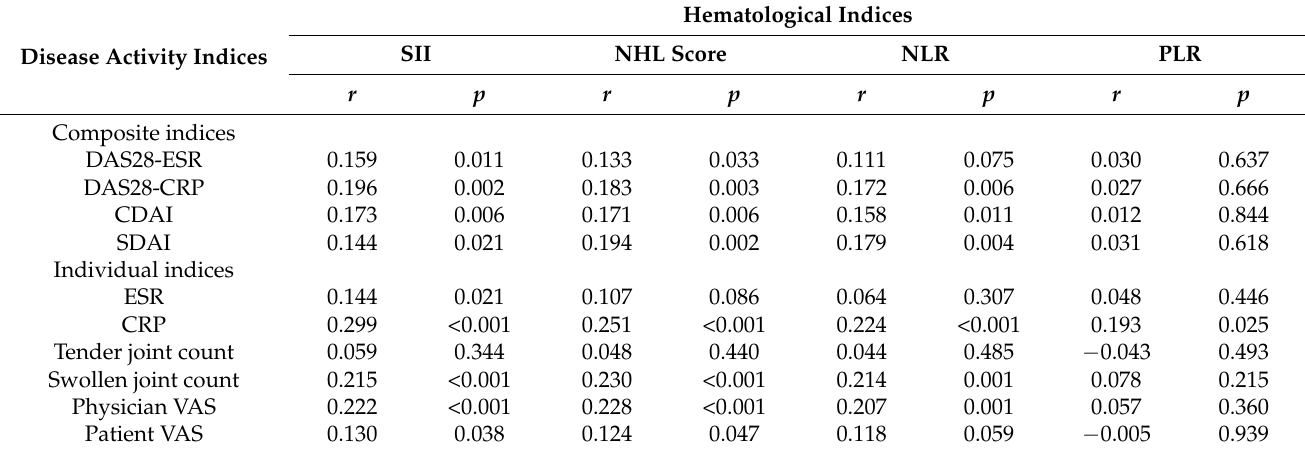
Table 3. Correlation between hematological indices and disease activity indices in rheumatoid